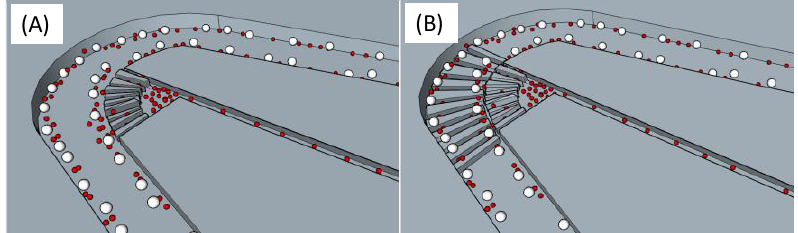
Figure 3. When the blood cells move along the curve channels, some of the smaller cells are sucked into the suction channels. Two designs — ( A ) without obstacle and ( B ) with an array of obstacles — are tested to compare the suction efficiency in the curve channels.